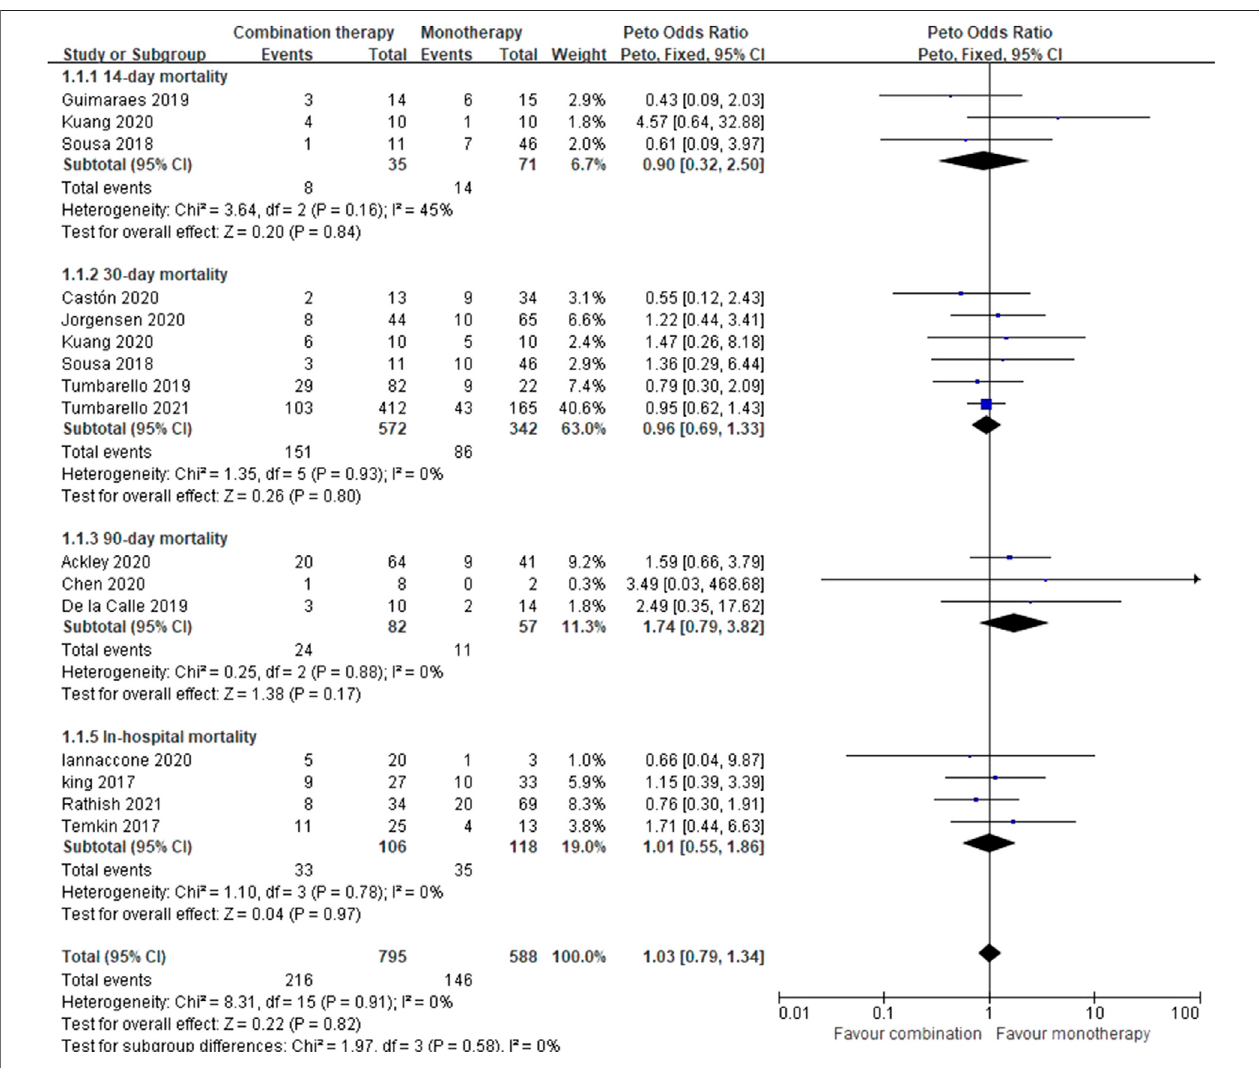
FIGURE 3 | Mortality of CAZ-AVI therapy alone versus in